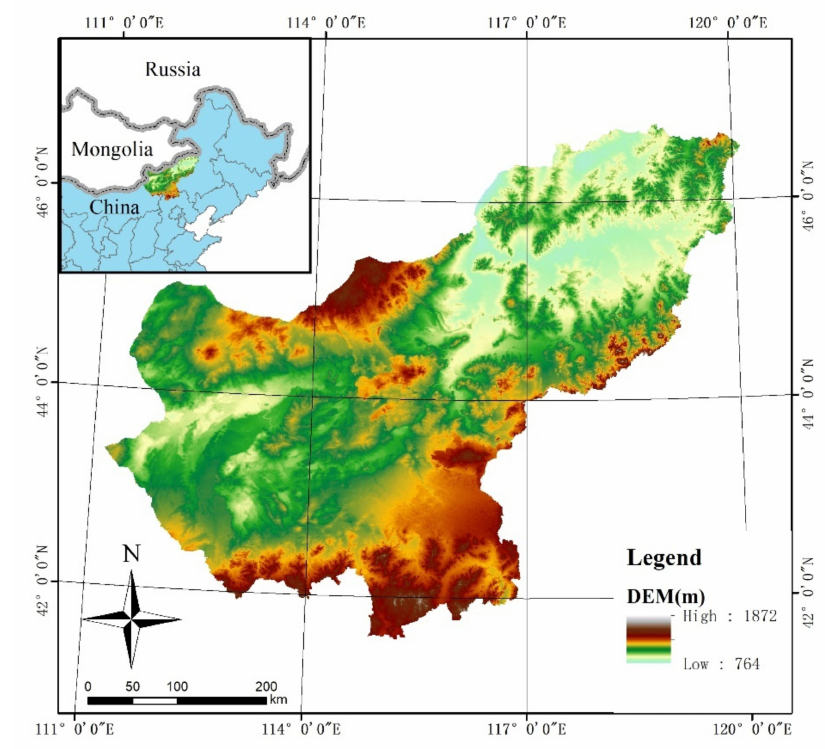
Figure 1. Location and terrain of the Xilin Gol